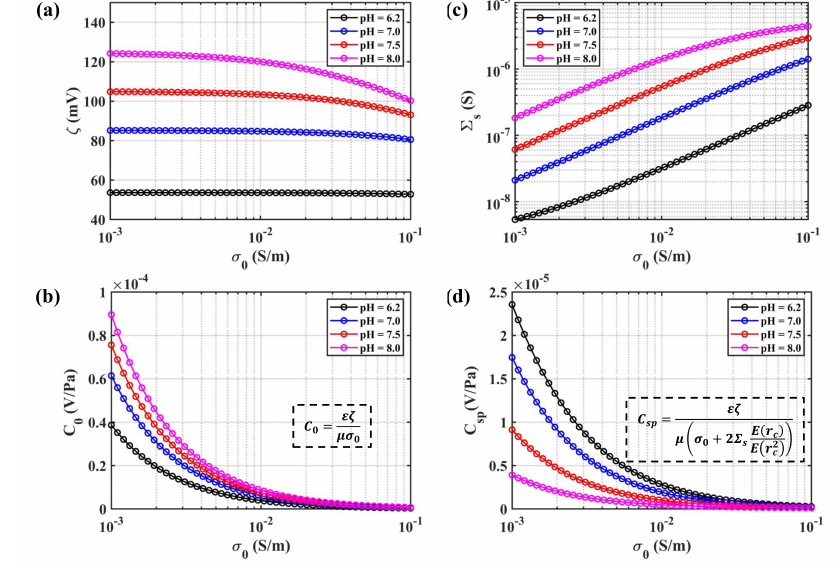
Figure 12. The pH dependence for different properties: ( a ) zeta potential ζ for different pH as a function of fluid conductivity; ( b ) steady SPC without considering surface conductivity C 0 for different pH as a function of fluid conductivity; ( c ) surface conductance Σ s for different pH as a function of fluid conductivity; ( d ) steady SPC with the consideration of surface conductivity C sp for different pH as a function of fluid